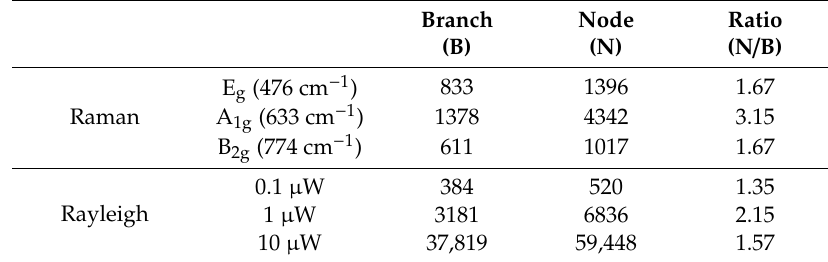
Table 1. Key parameters measured from Raman and Rayleigh scattering, depending on the site of the optical excitation: branch (B) or node (N), and ratio N/B of corresponding signal amplitudes.